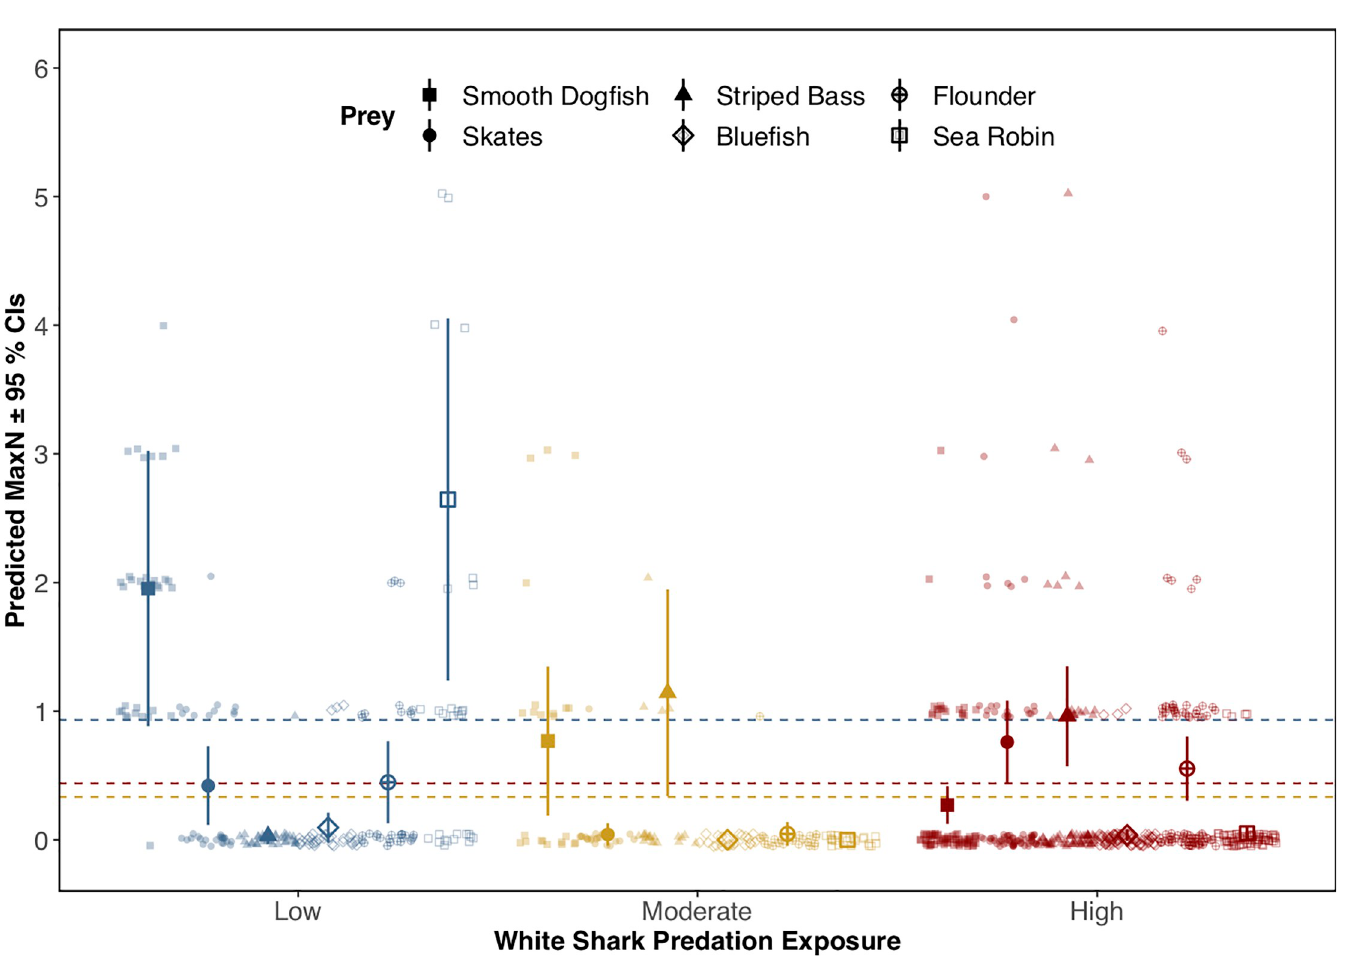
Fig 4. Predicted prey abundance across a gradient of shark exposure. Predicted prey abundance (MaxN; ± 95% confidence intervals) from a negative binomial Generalized Linear Model (GLM) for six different prey groups across varying levels of shark exposure. Predicted values, as well as mean abundance by exposure level (dashed lines), are overlaid on top of raw observational data. Confidence intervals are not included for prey groups not observed within a given exposure level.